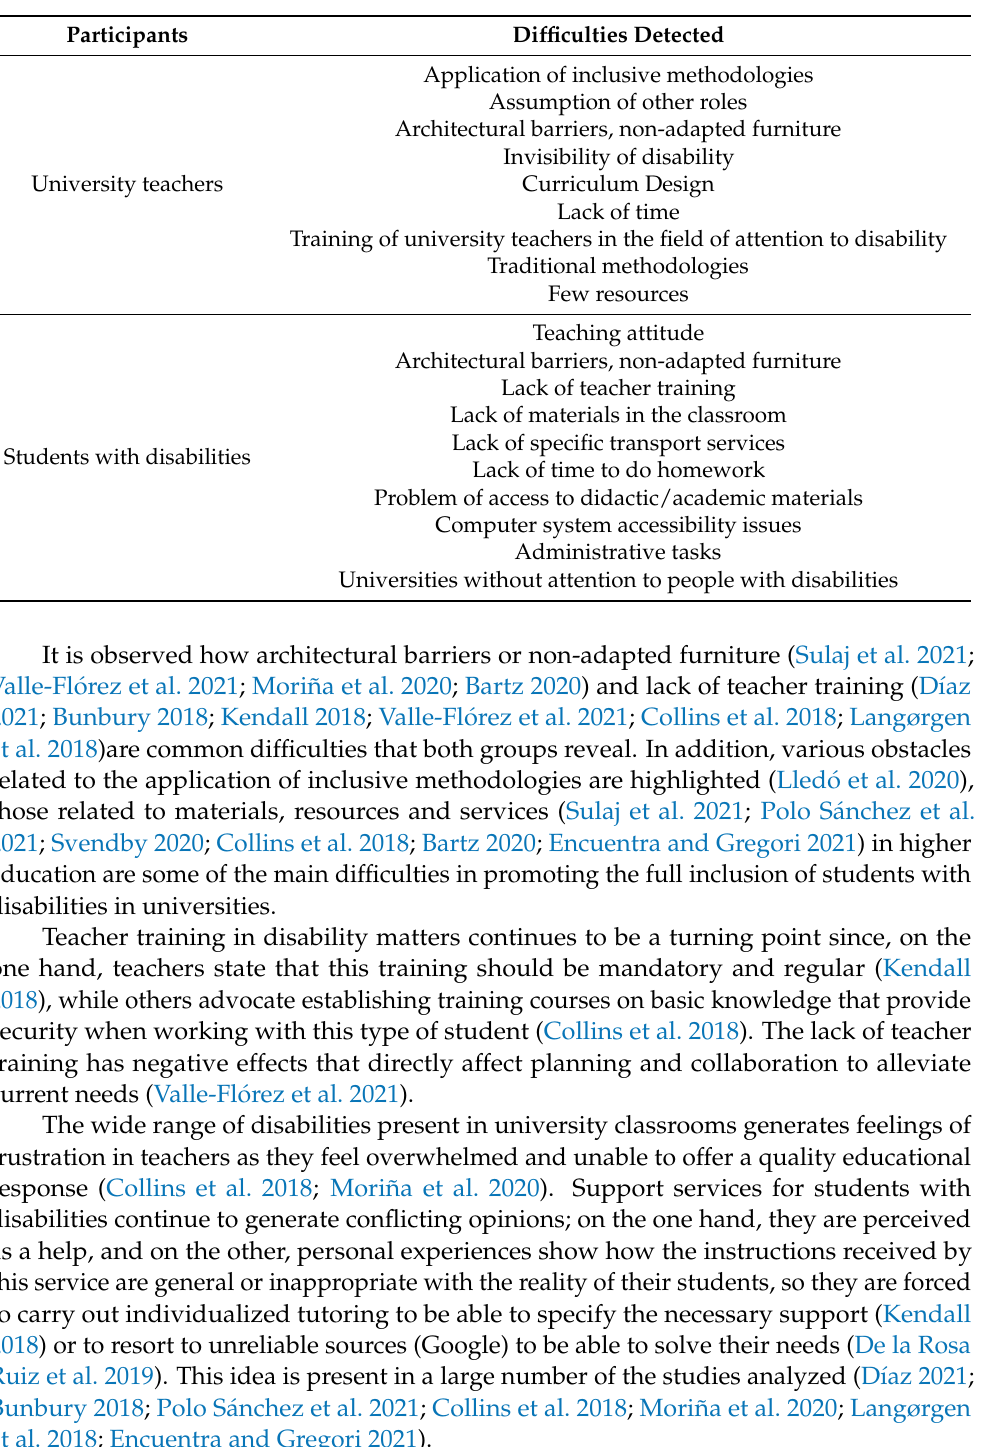
Table 3. Main obstacles in the educational response to university students with